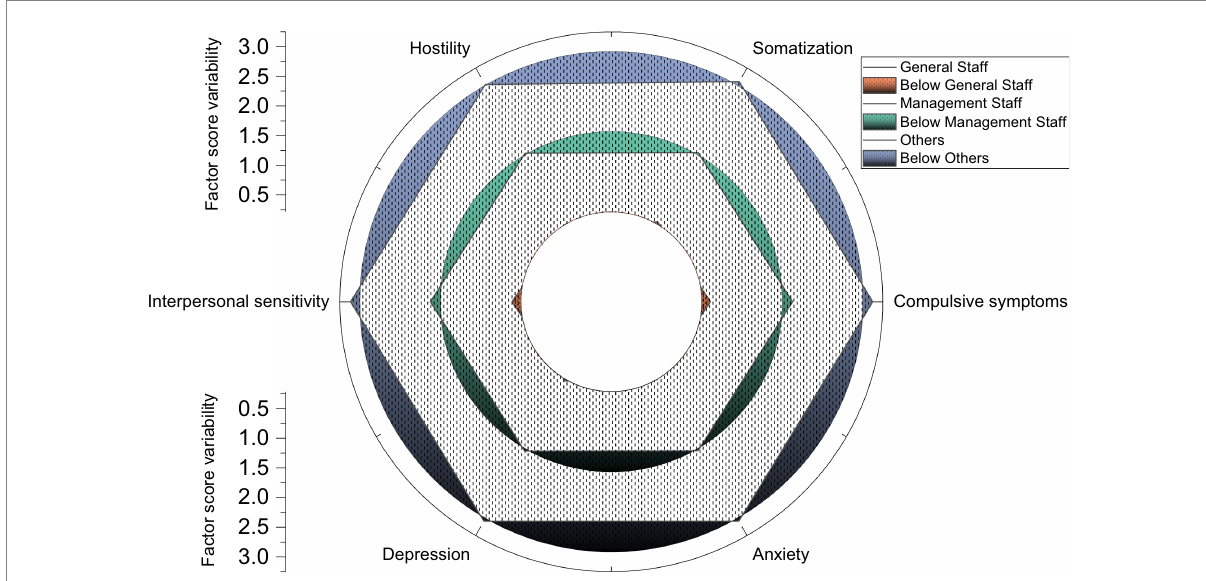
FIGURE 5 Comparison of the total mean score and the variability of each factor score of the symptom self-assessment scale for employees in different